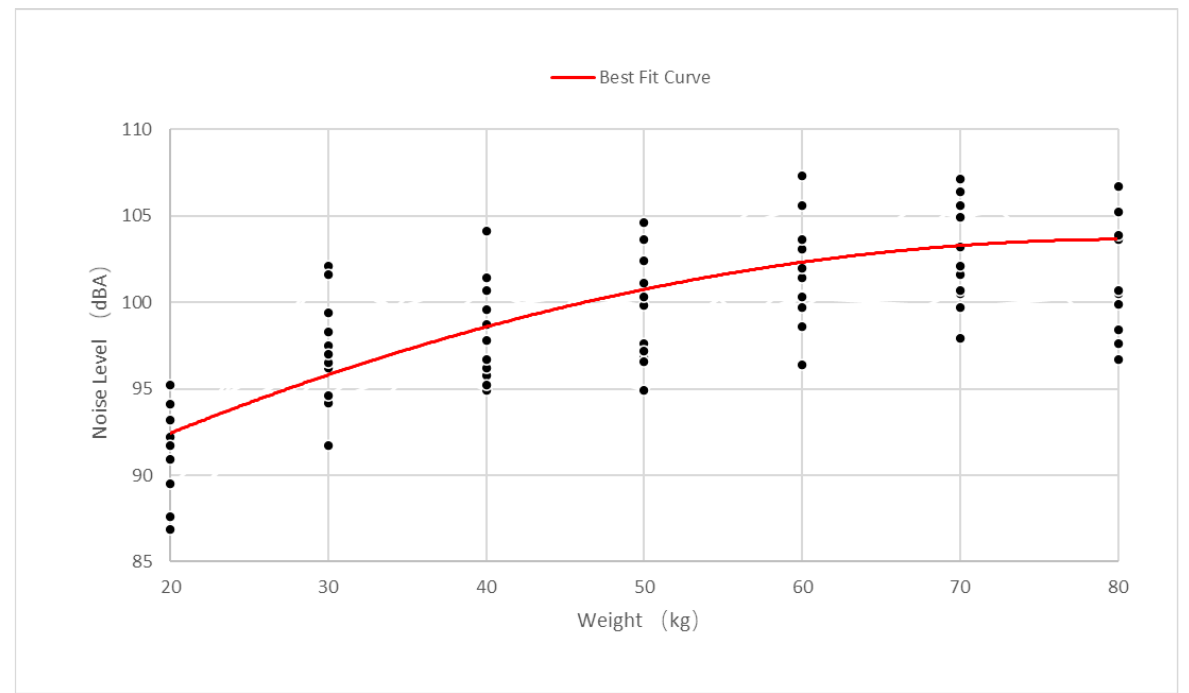
Figure 6. Noise and dose versus drop weight. Table 4. Comparison of noise